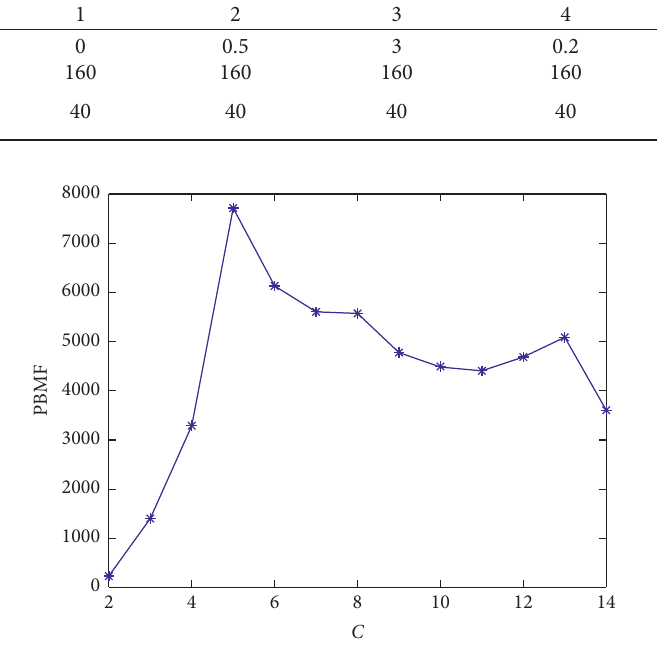
Figure 14: The change of PBMF with cluster number c .